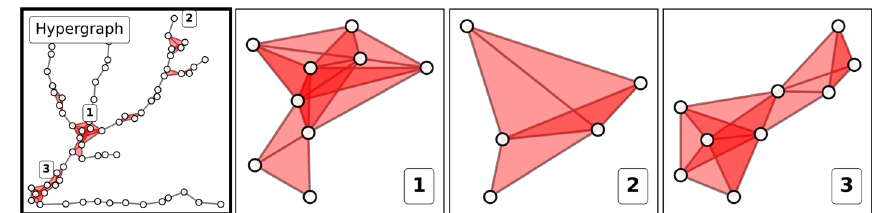
Fig. 1 Hypernetwork construction. Higher order structures are built using edges and triangles as hyperedges. The leftmost panel shows one of the studied graphs together with the triangles (in red)